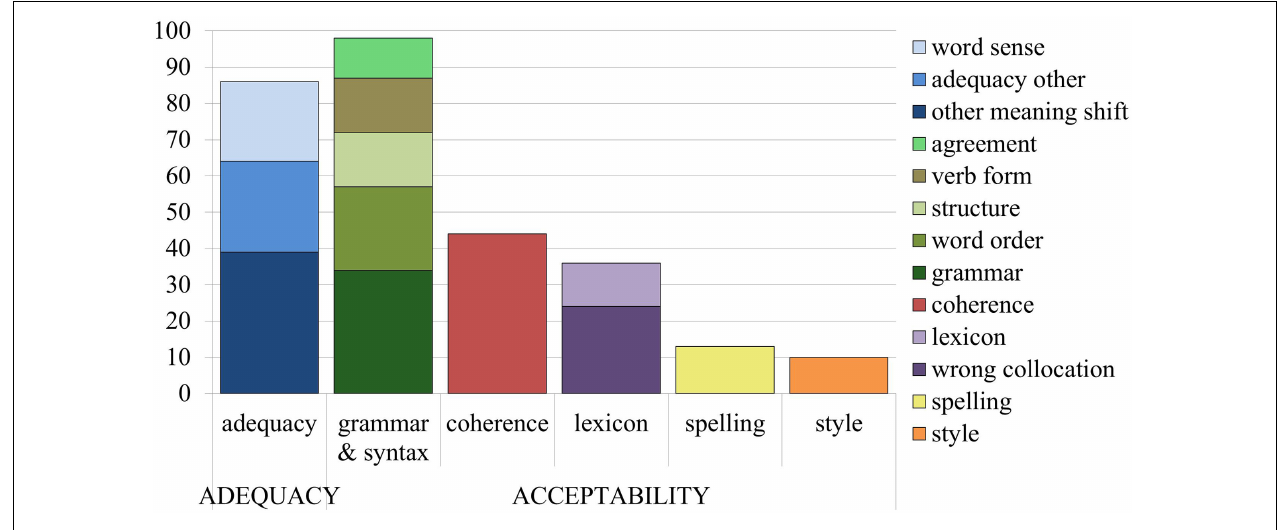
FIGURE 1 | Error type frequency in the MT